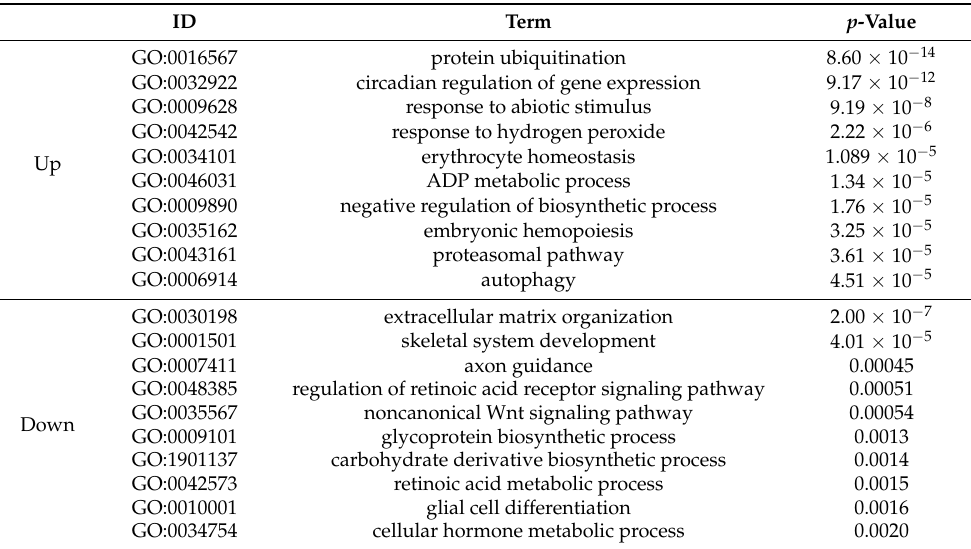
Table 2. Gene ontology enrichment analysis of the intersect proteins of gene